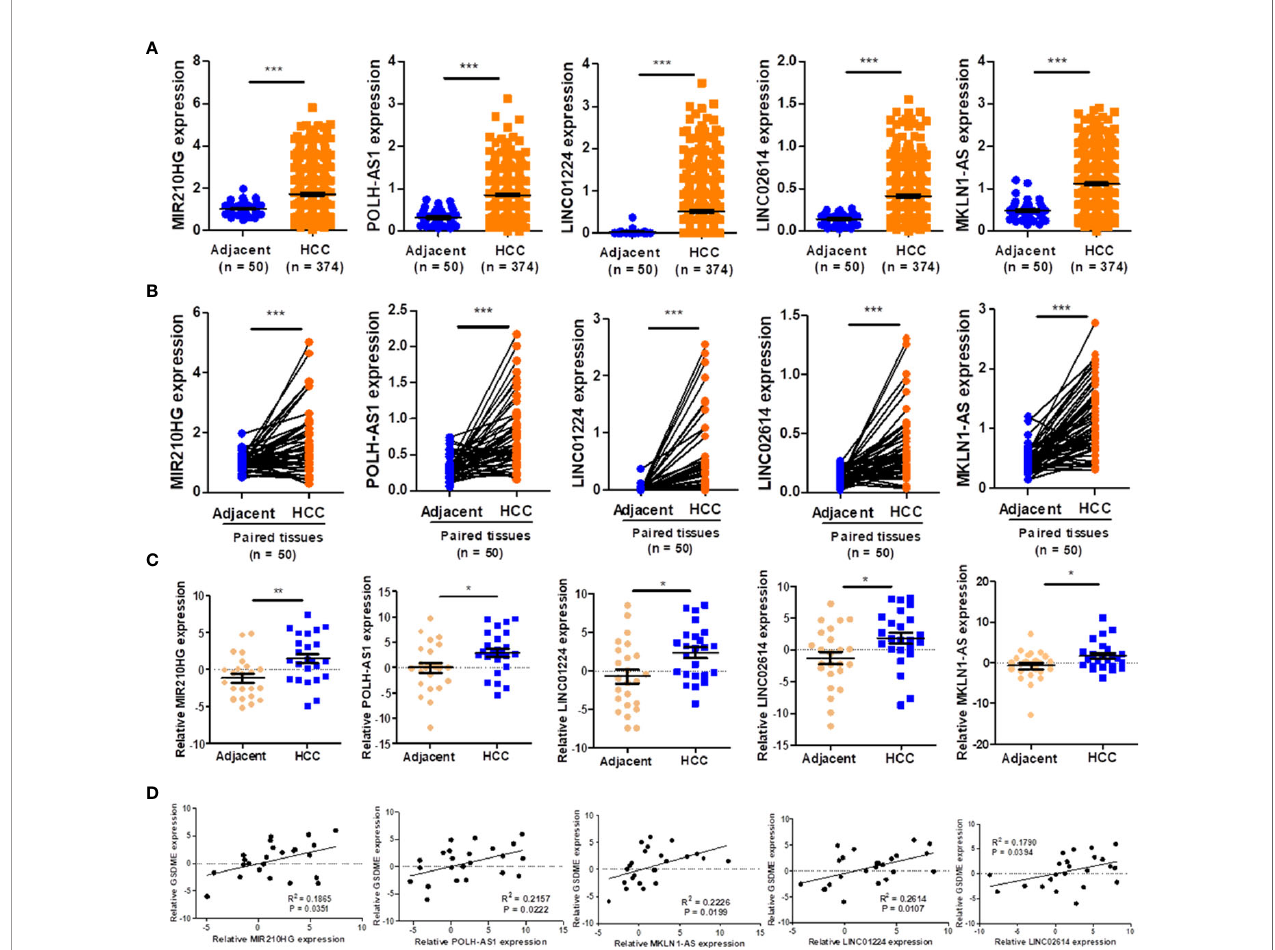
FIGURE 9 | Validation of the expression of fi ve lncRNAs. (A) The expression level of fi ve lncRNAs in HCC and adjacent tissues, as indicated by TCGA_LIHC dataset. (B) Five lncRNAs in HCC and paired adjacent tissues according to the TCGA_LIHC dataset. (C) The expression of fi ve lncRNAs in twenty-four pairs of HCC tissues and adjacent tissues veri fi ed using qRT-PCR (n = 24). (D) Associations of pyroptosis-related gene, GSDME and fi ve lncRNAs expression levels veri fi ed using qRT- PCR (n = 24). *P < 0.05, **P < 0.01, ***P <